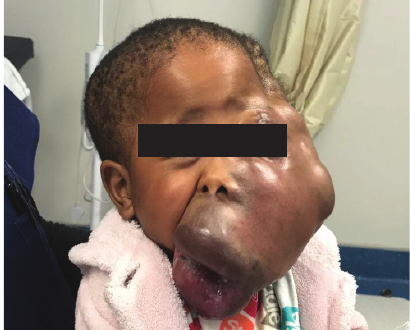
Figure 5. Patient with Sturge-Weber syndrome sedated with dexmedetomidine 3 ug/kg + ketamine 0.25-0.5 mg/kg IV followed by an awake